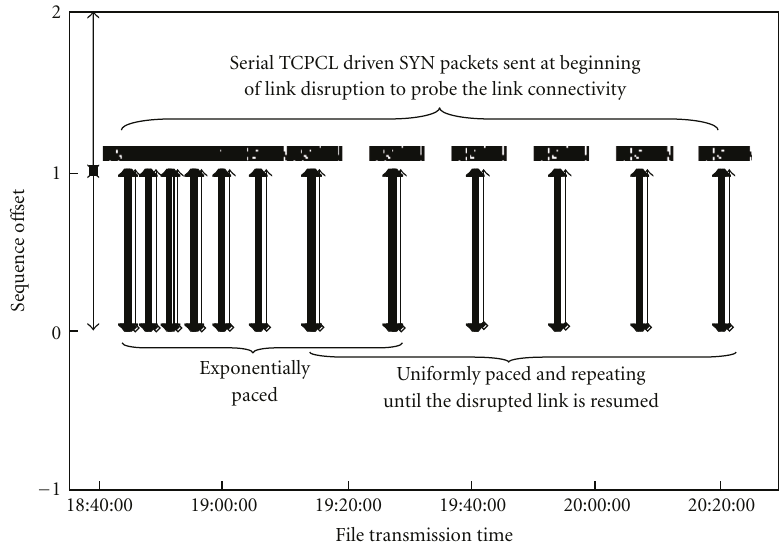
Figure 9: Enlarged view of serial SYN/R SYN packets sent from MX to RX during link disruption over cislunar